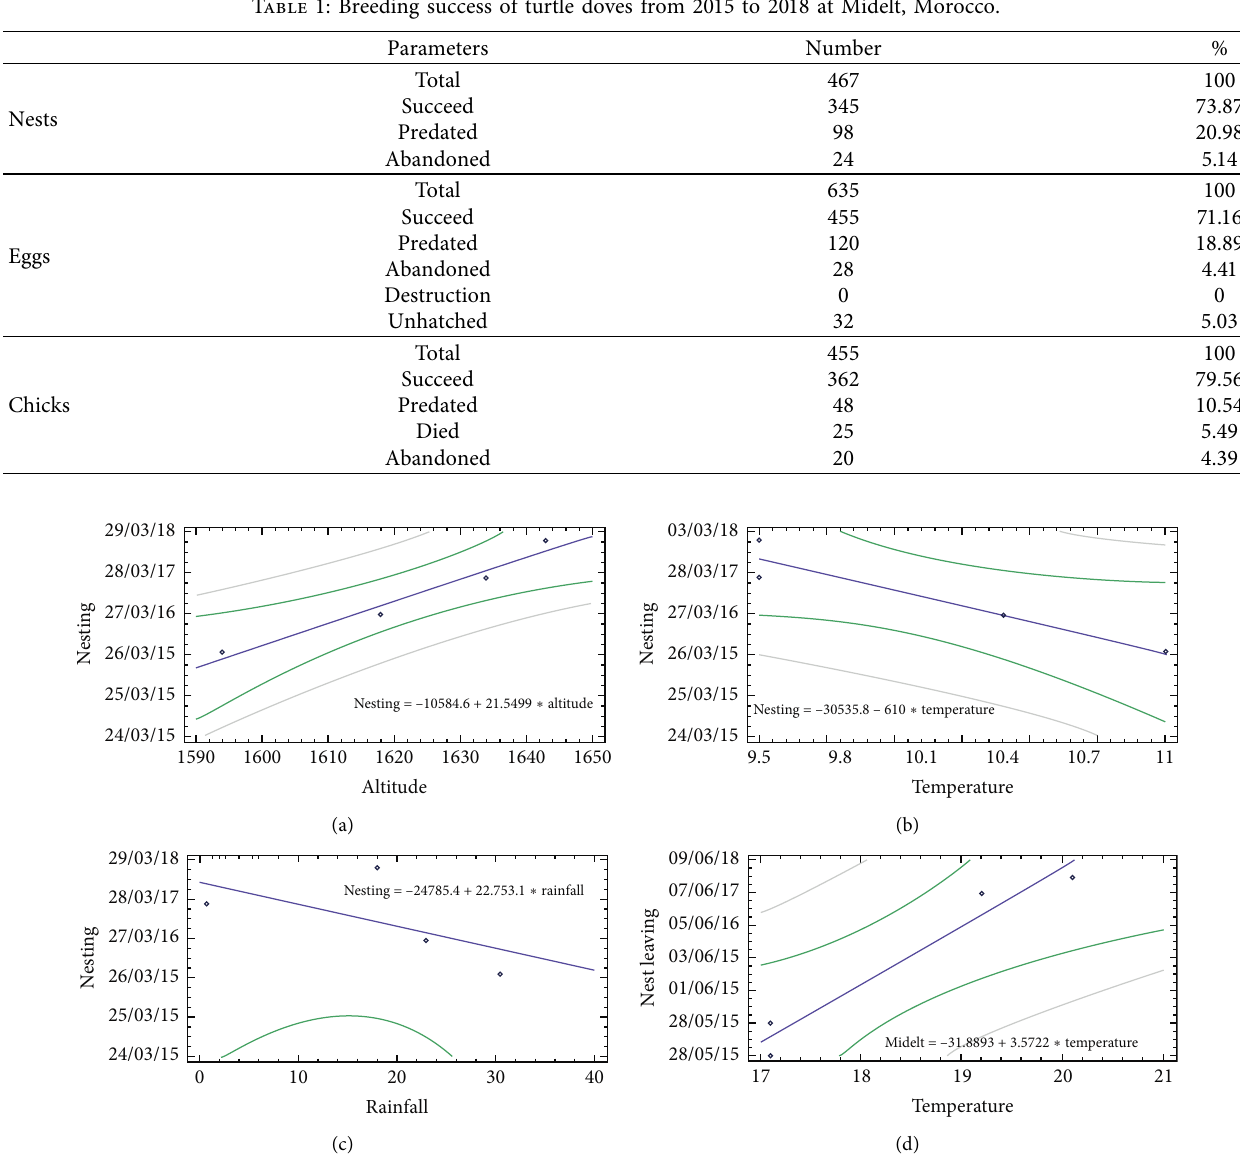
Table 1: Breeding success of turtle doves from 2015 to 2018 at Midelt, Morocco.